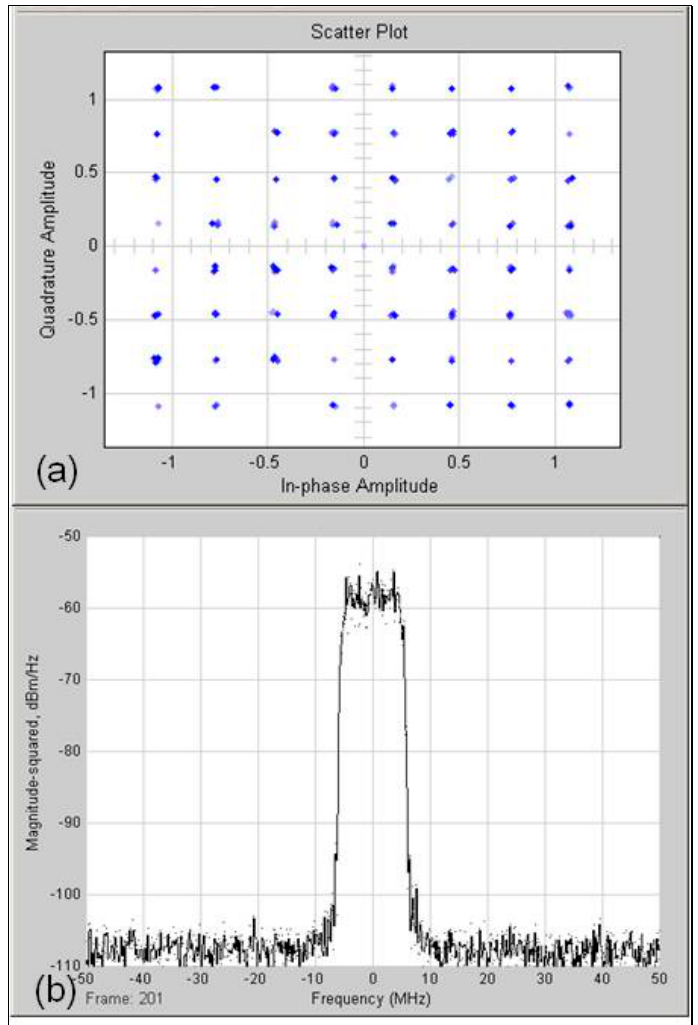
Figure 9. ( a ), Constellation and ( b ) spectrum of transmitted signal on all OAM modes (OAM1 + OAM8).